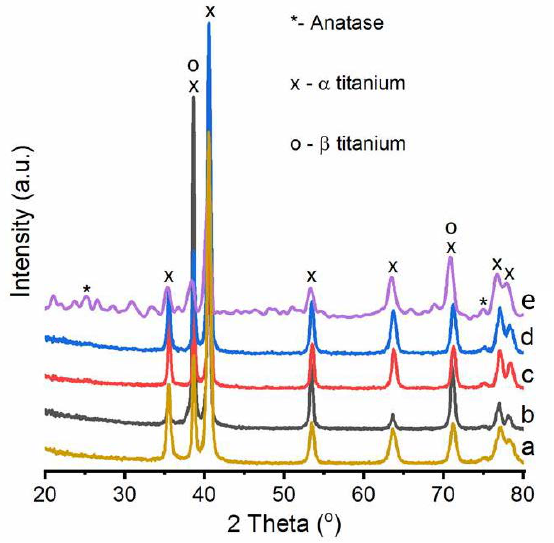
Figure 7. XRD patterns of SLM and AECT surfaces. ( a ) SLM, ( b ) AECT-1, ( c ) AECT-2, ( d ) AECT-3 and ( e ) AECT-4.